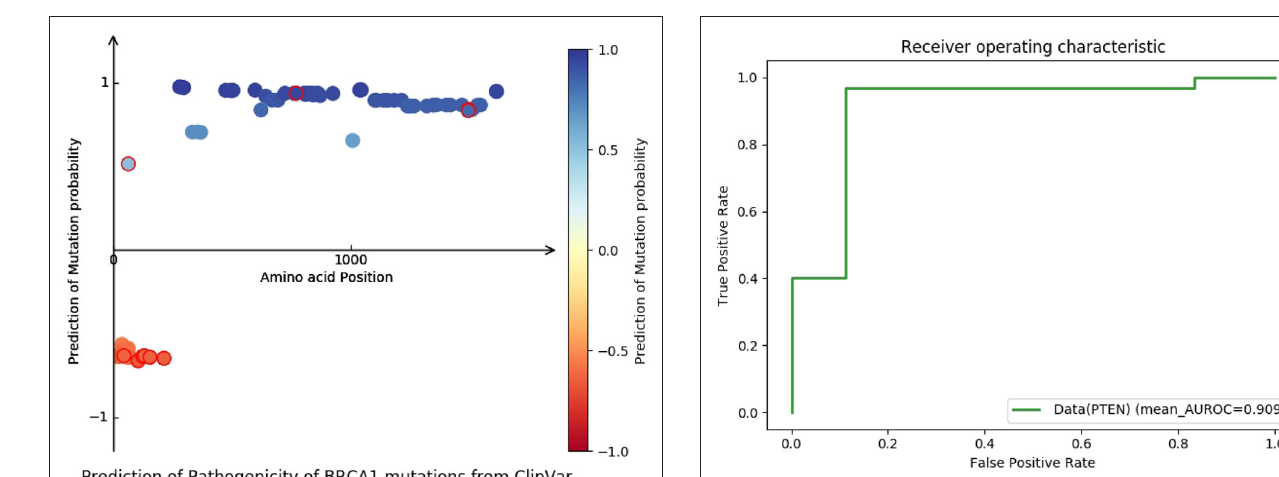
FIGURE 5 | Predictive performance of BertVS on the BRCA1 dataset from ClinVar. The distribution of predicted probabilities and locations of BRCA1 mutations in ClinVar. The x-axis is the mutation position, and the y-axis is the predicted probability of the mutation.